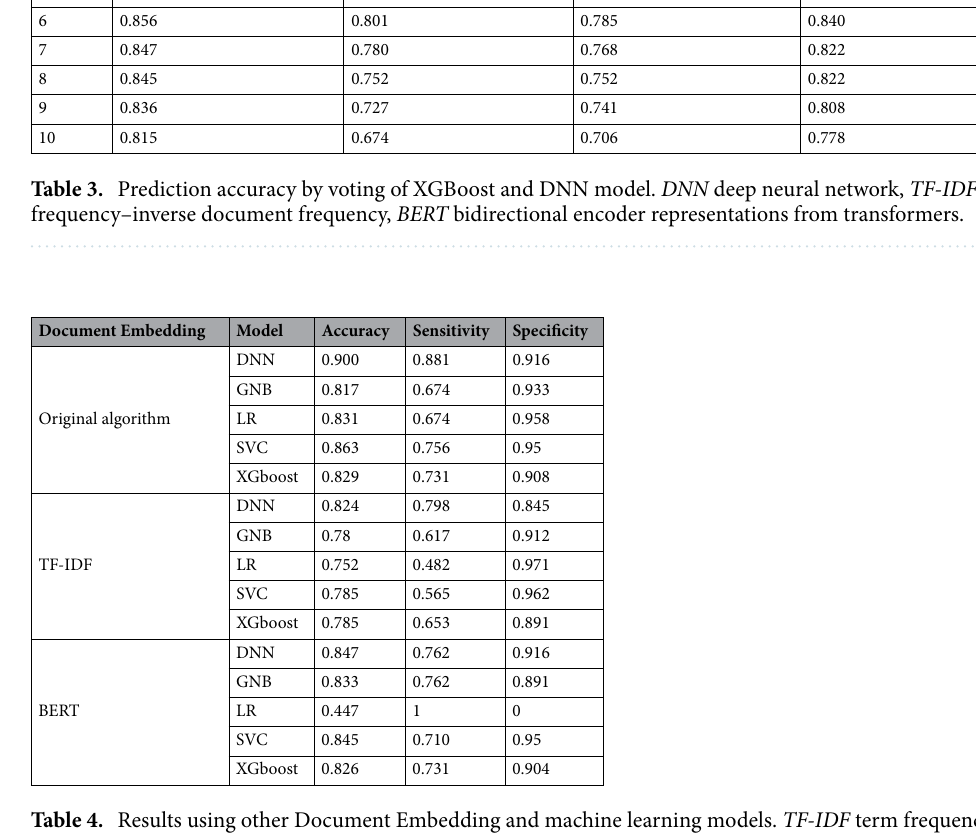
Table 4. Results using other Document Embedding and machine learning models. TF-IDF term frequency– inverse document frequency, BERT bidirectional encoder representations from transformers, DNN deep